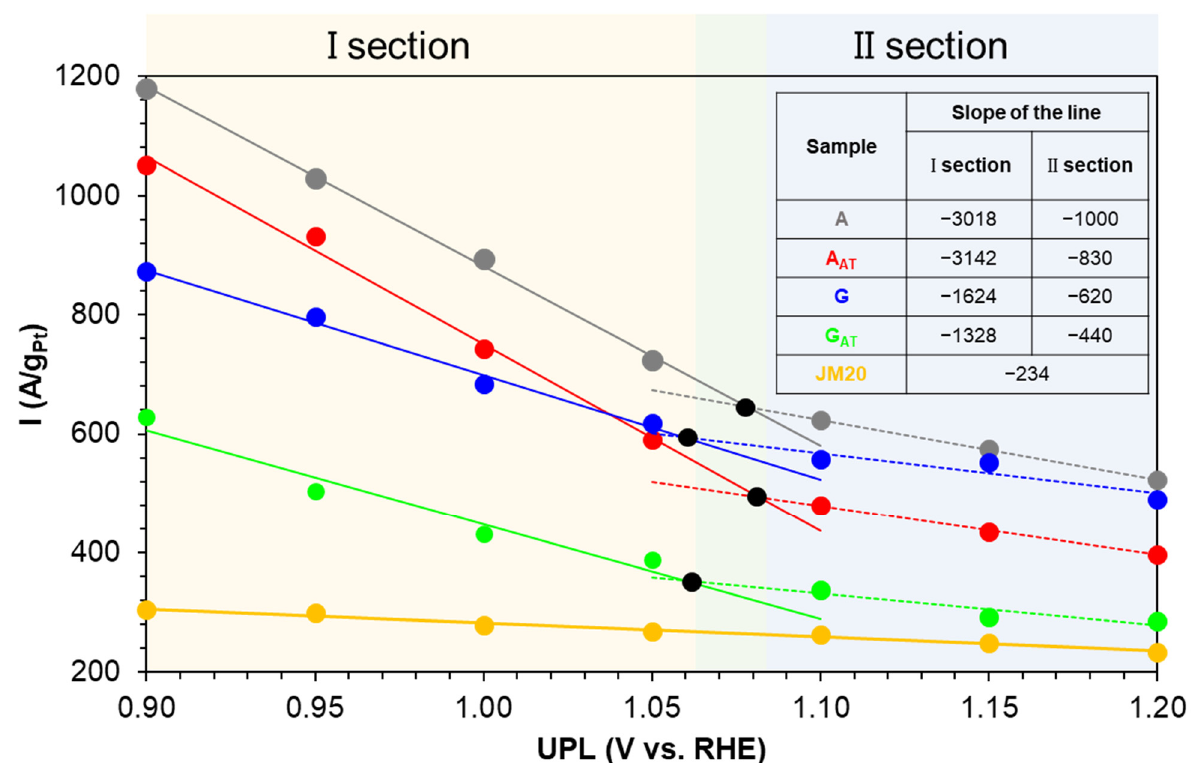
Figure 6. The dependence of the UPL on the mass activity. The color of the markers in the figure corresponds to the color of the material in the table (inset).